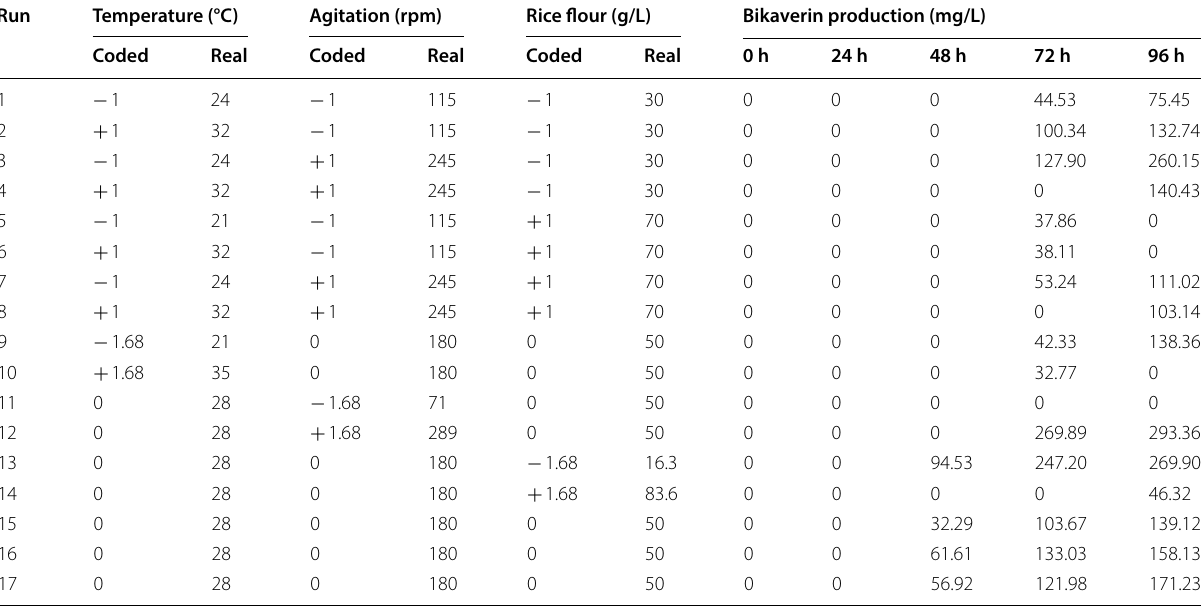
Table 2 Bikaverin production (mg/L) by F. oxyporum CCT7620 for each experimental condition defined by the central composite rotational